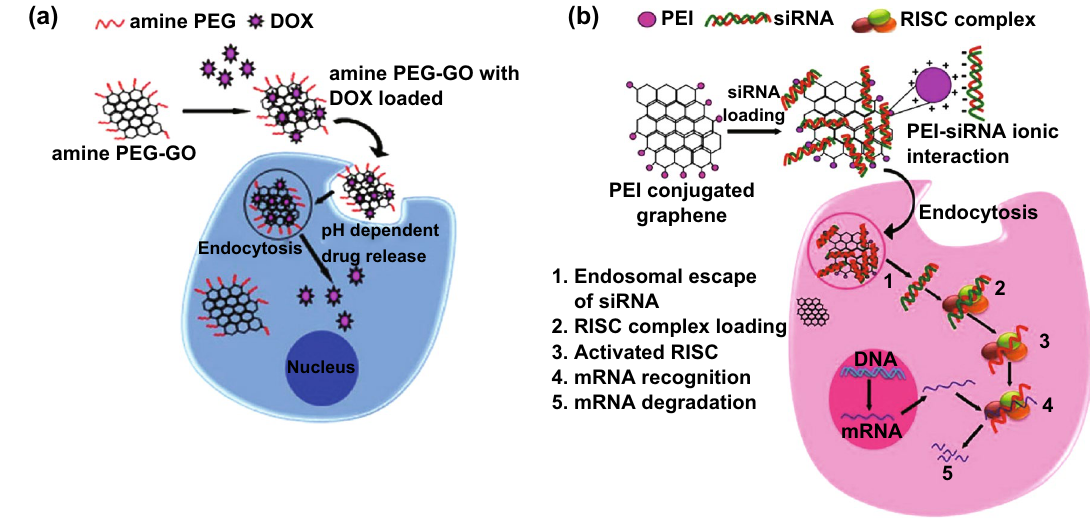
Fig. 2 Drug and gene delivery applications. a Delivery of doxorubicin using amine-PEG-functionalized GO. b siRNA delivery and mRNA deg- radation using PEI-conjugated GO for gene silencing technology (RISC—RNA-induced silencing